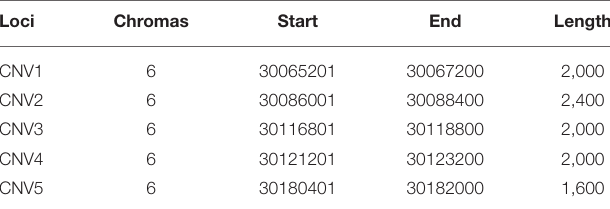
TABLE 2 | Information on the copy number variations within the goat Fec B gene.